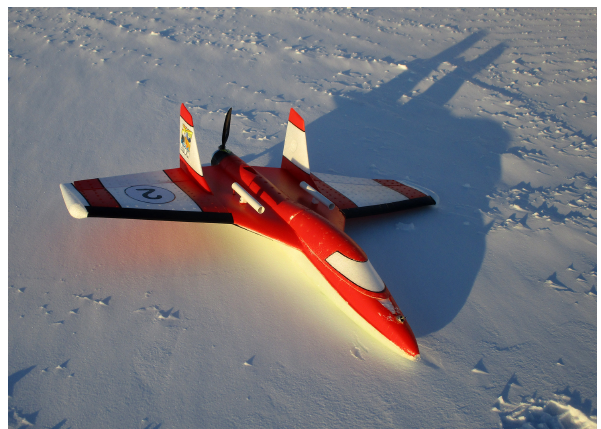
Figure 2. SUMO sUAS at the Pegasus ice runway outside of Mc- Murdo Station,